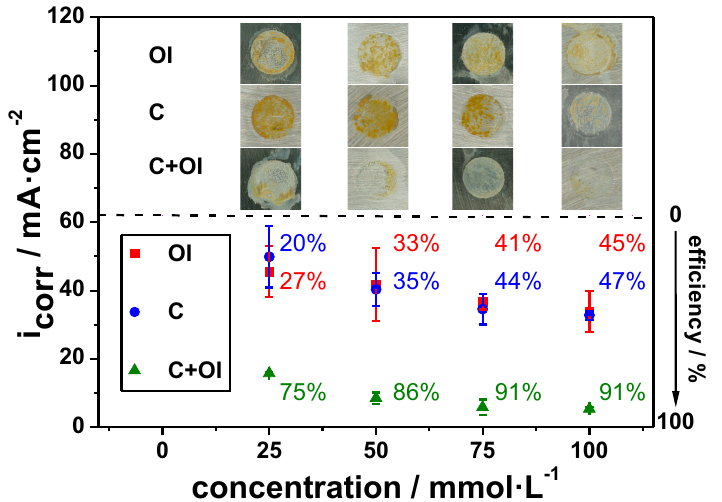
Figure 3. Corrosion current density and IE for different concentrations of C (blue), OI (red), and C + OI (green) during PP measurement of steel CR4 in 0.1 M NaCl. The included images present exemplary degraded samples after the electrochemical test. The result of the untreated material is given as a black dashed line at 62 µ A/cm 2 , respectively, as 0% efficiency, for reference on the right. Compound OI, which was intended as a synergist, had individually even less effect than compound C. A decrease in current density with a small potential shift in negative direction led to a maximum efficiency of only 45% for 100 mmol/L (Table 3 and Figure 3 in red). The remaining OI concentrations showed some variations but rarely exceeded the values of C, except for 25 mmol/L with about 27% compared to roughly 20% for